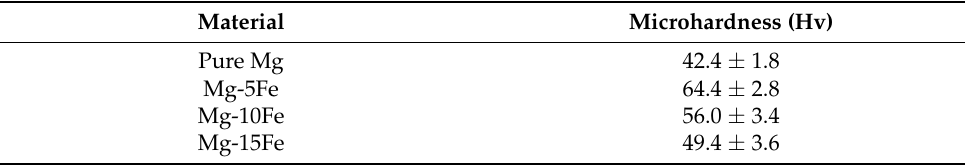
Table 2. Microhardness values of pure Mg and Mg-Fe